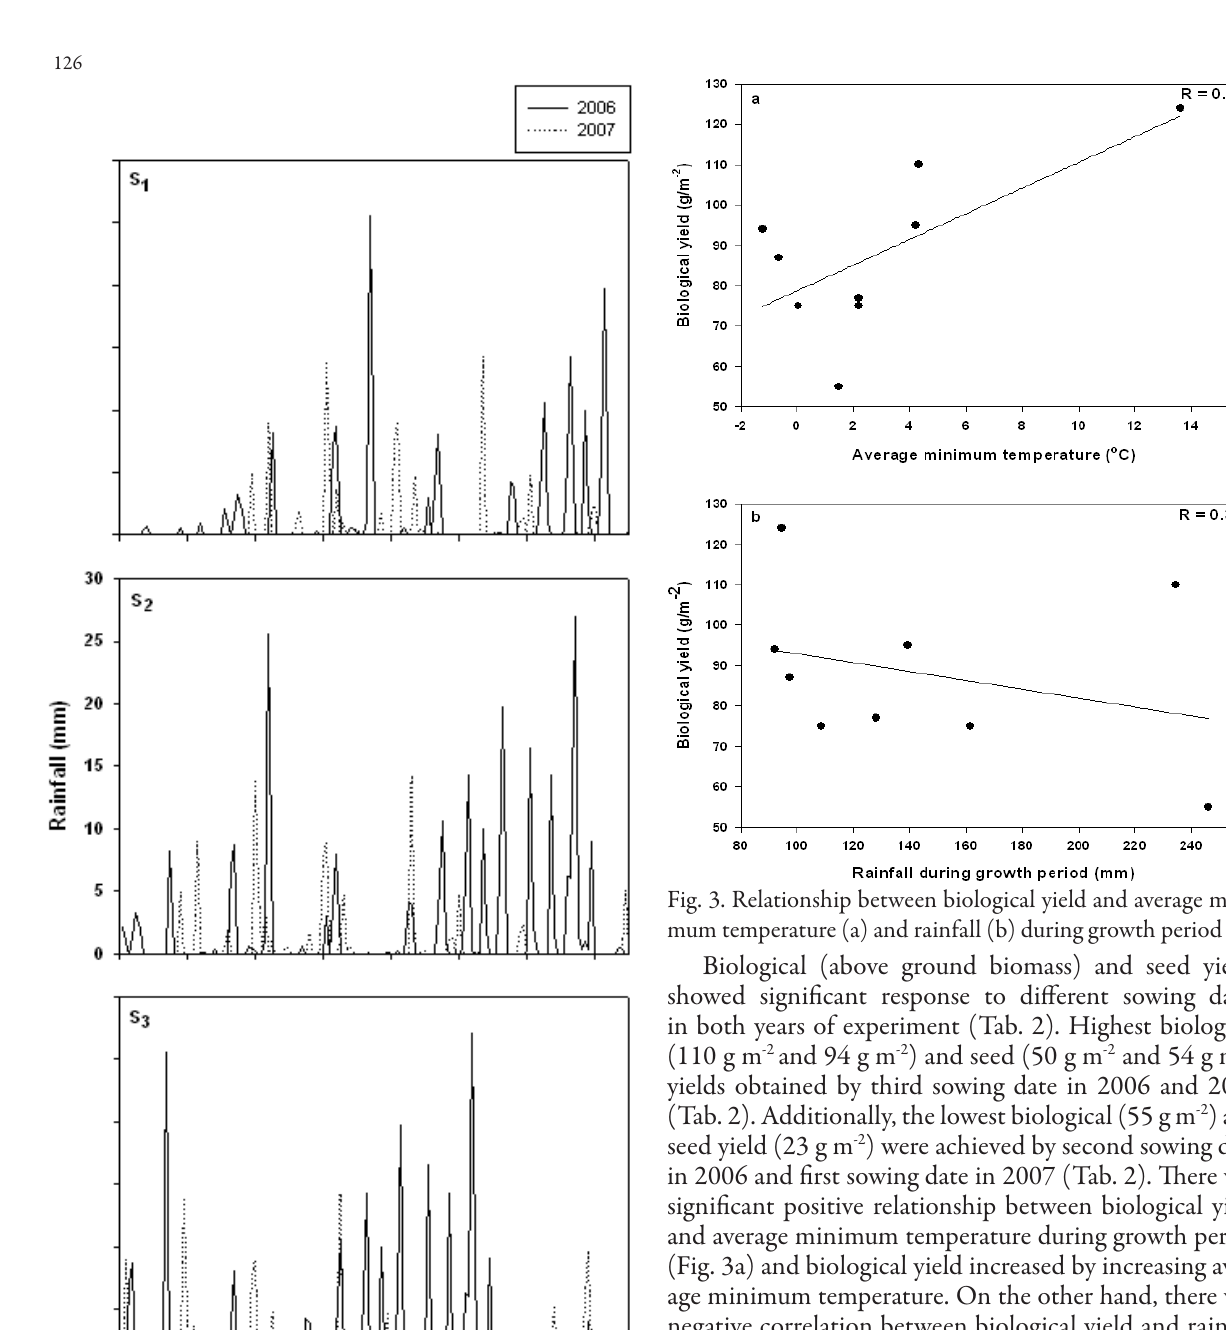
Fig. 2. Daily values of rainfall in different sowing dates in 2006 and 2007 (mid October (S cember (S )) 3